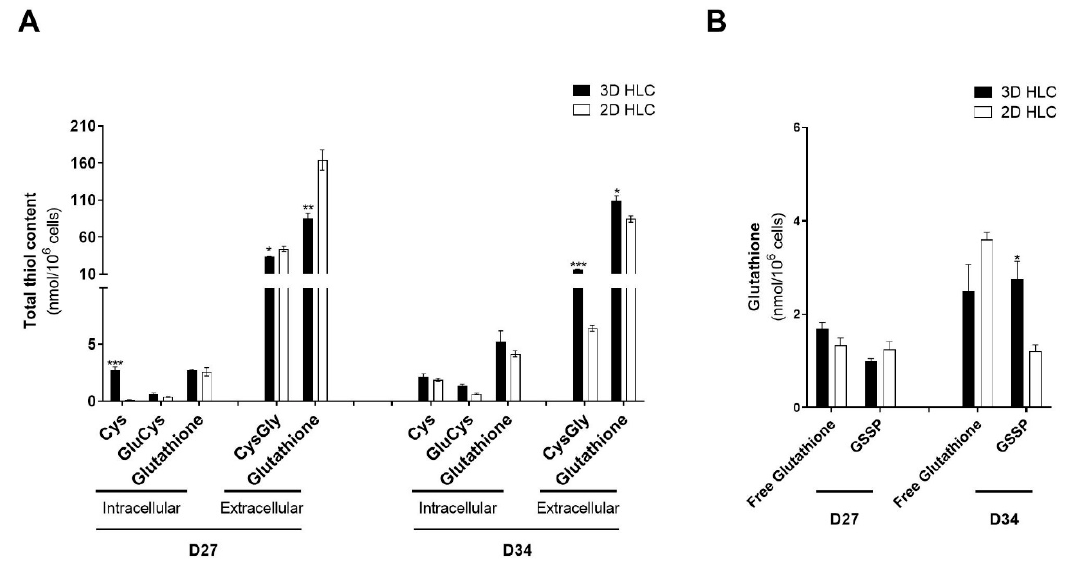
Figure 5. Glutathiolomic analysis of 3D- and 2D-HLCs at D27 and D34. ( A ) Total intracellular availability for cysteine (Cys), glutamylcysteine (GluCys) and glutathione and total extracellular levels of cysteinylglycine (CysGly) and glutathione; ( B ) Intracellular levels of protein-bound glutathione (GSSP) and free glutathione; * p < 0.05, ** p < 0.01 and *** p < 0.001 relative to 2D-HLCs. The data are represented as Mean ± SD, n = 3.